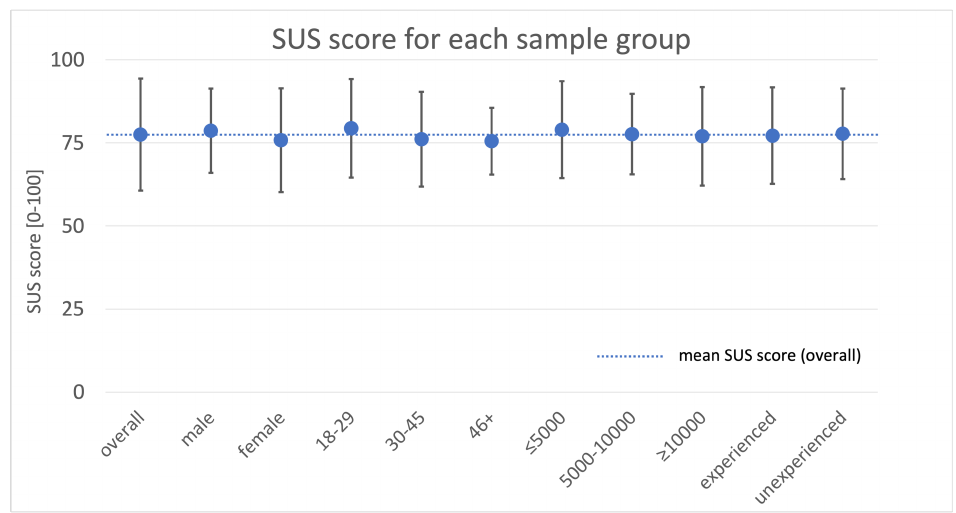
Figure 8. SUS score for the demographic sample groups.